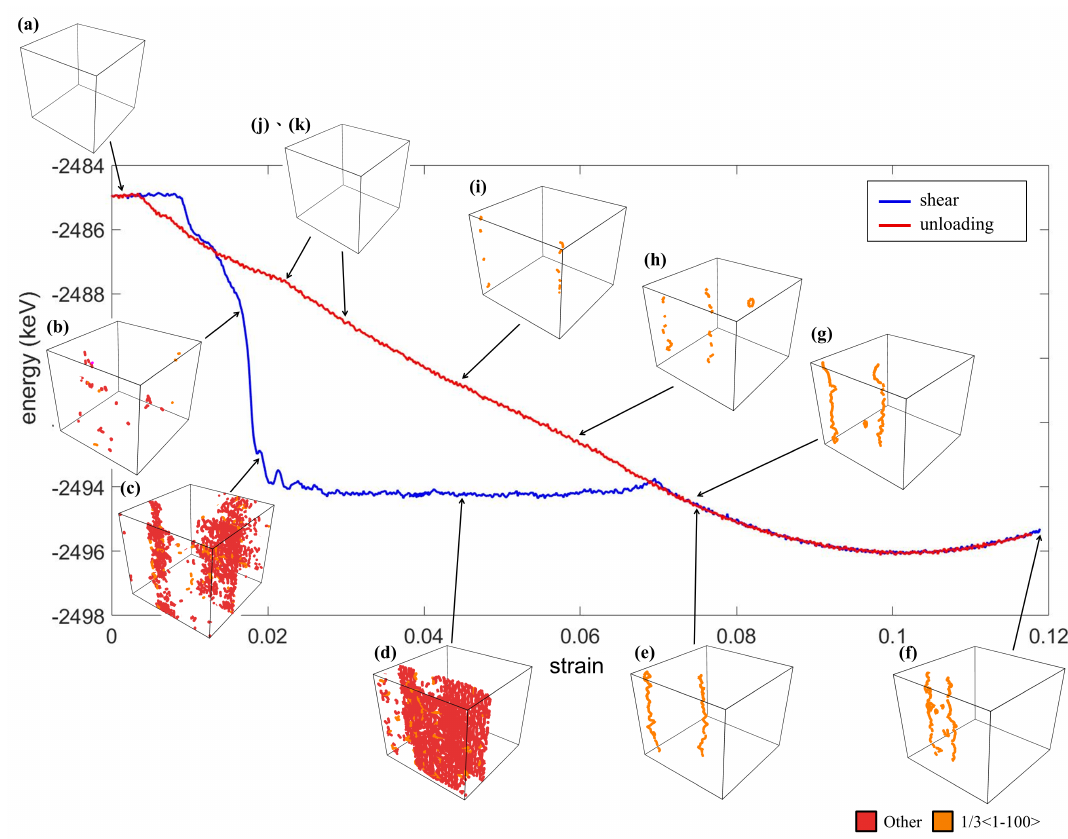
Figure 10. The energy profile and the evolution of dislocation at Stages ( a – k ) during the xy